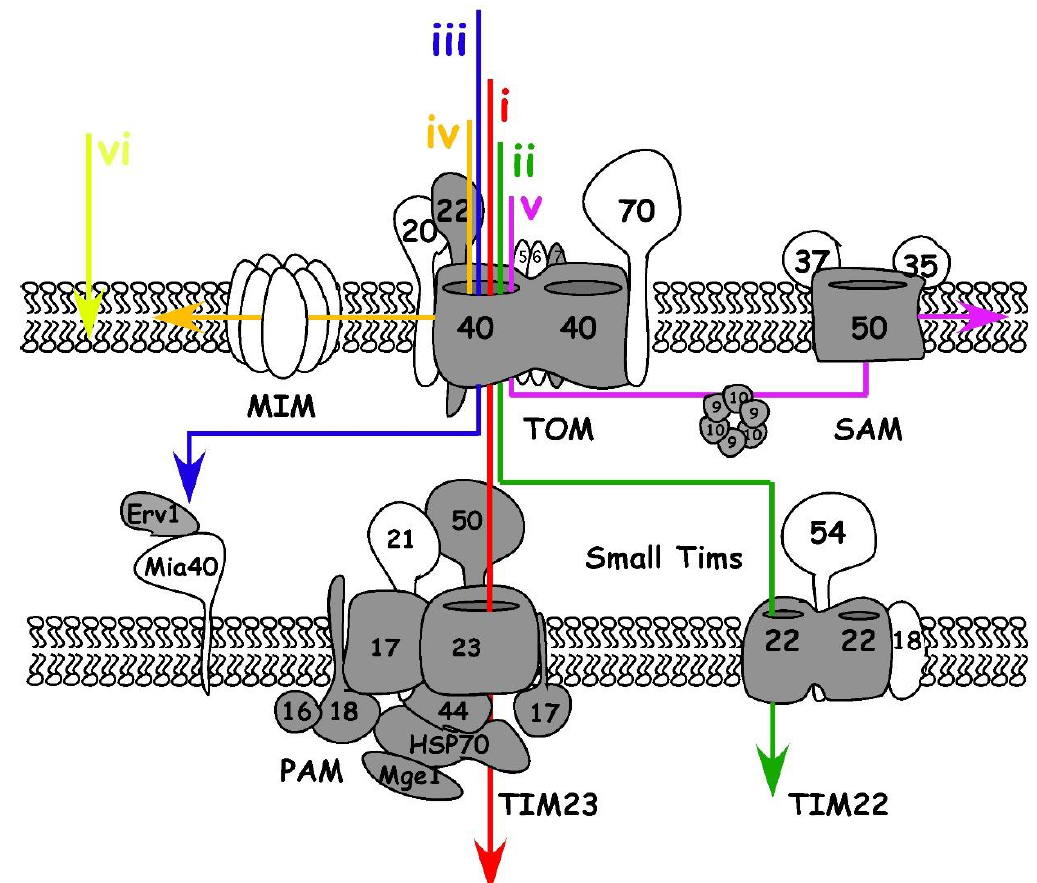
Figure 1. Complexes and route of protein entry into the mitochondrial compartments. The colored lines depict the routes of protein translocation into the different compartments of the yeast mitochondria (detailed in the “signals targeting precursors to the mitochondrial sub-compartments” section). Known components of the yeast translocation complexes are shown and those for which homologues are found in the genomes of Toxoplasma and Plasmodium spp. are in grey. MIM: mitochondrial import